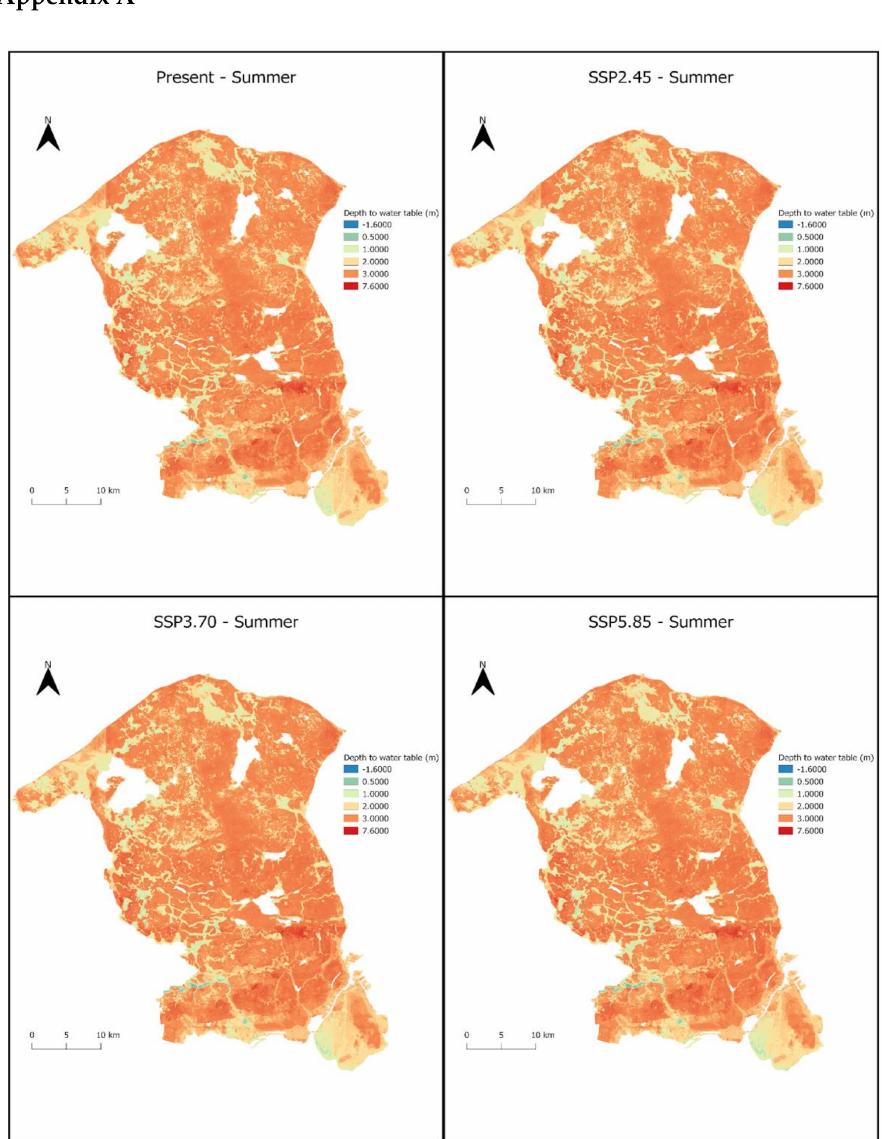
Figure A1. Comparison of the resulting maps based on the predictions made with the RF model for the different climate change scenarios, for the summer season. The maps show the depth to the water table in meters, where negative values represent water over the surface of the terrain, and positive values show the water table found under the